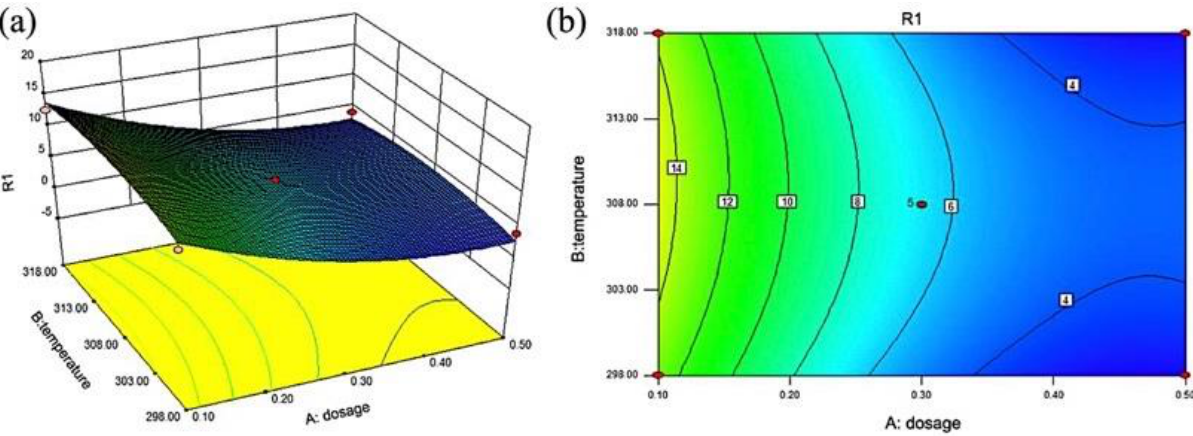
Figure 10. The ( a ) three-dimensional view and ( b ) top view for interaction between dosage D and experimental temperature.